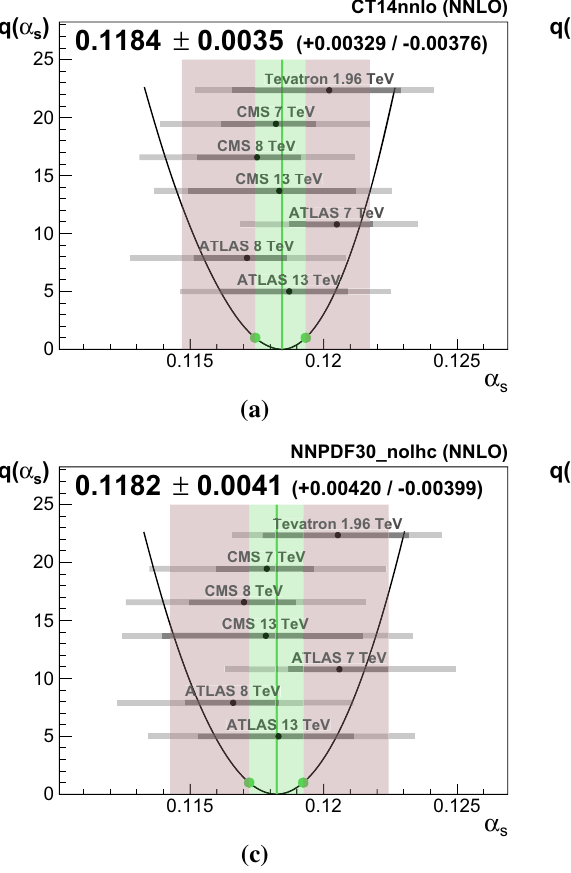
statistic q asafunctionof α s isplottedasablackline.Thegreenlineand band represent the central value of the combination and the 1 σ confi- dence interval, respectively. The red band depicts the total combination uncertainty with scale, PDF and top-mass uncertainties included